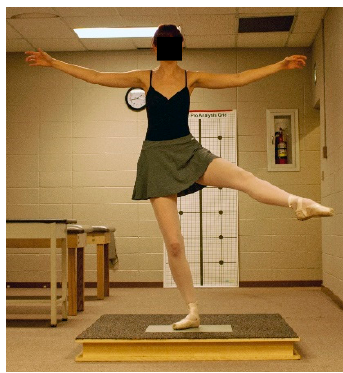
Figure 8. Jumping landing in plié on the force plate for sissonne ouverte de côté.